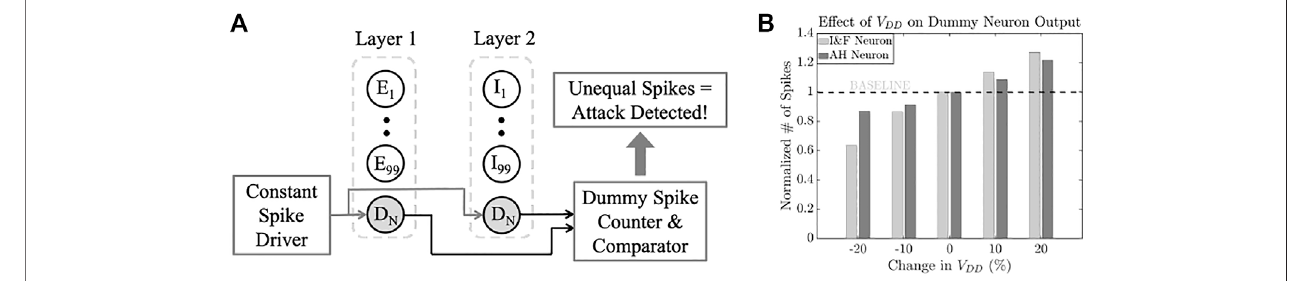
FIGURE 17 | (A) V DD change detection using dummy neuron; and (B) effect of V DD on dummy neuron